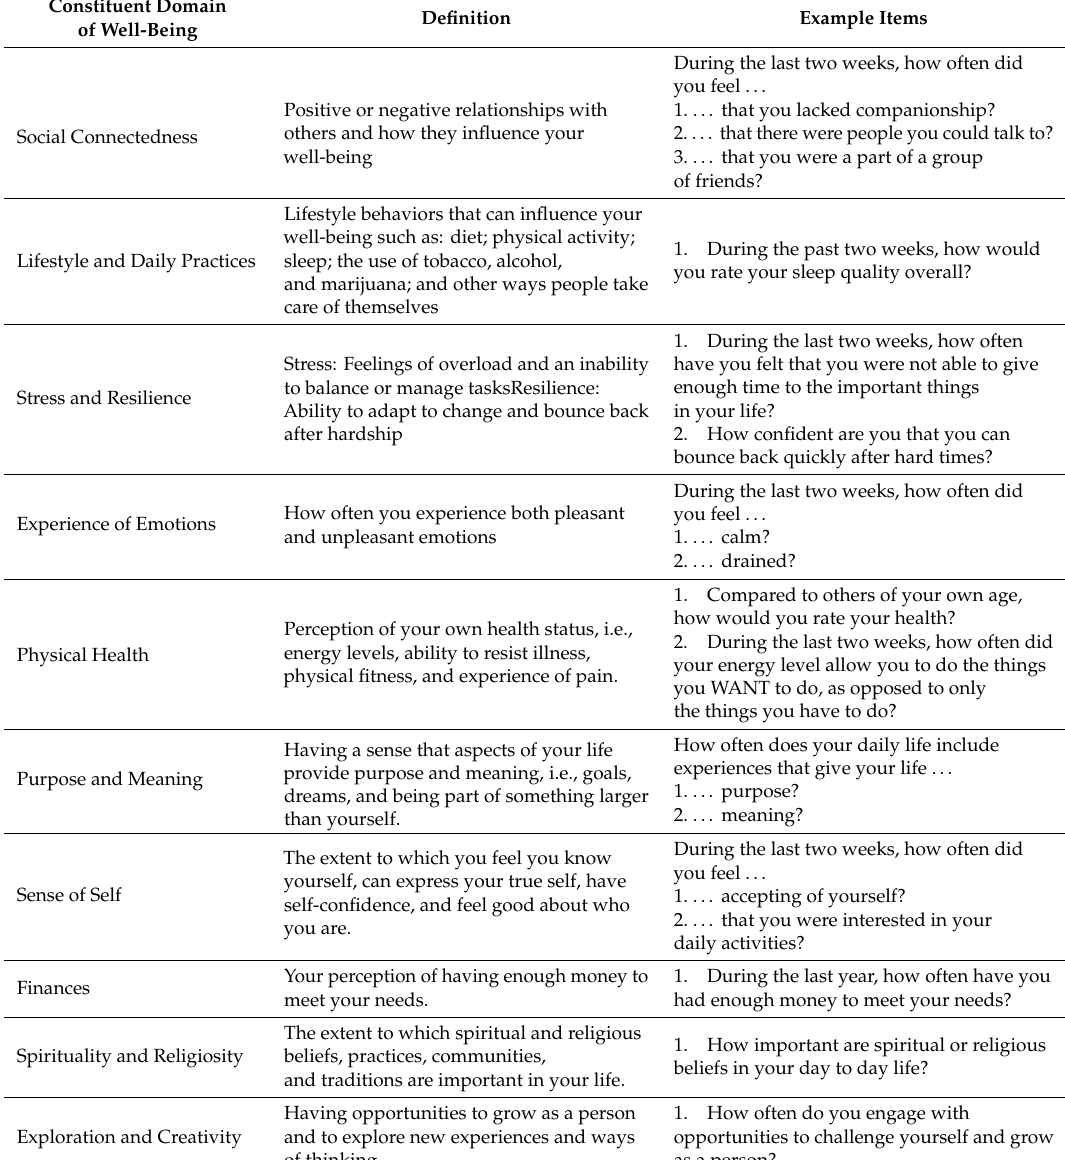
Table 1. Definitions of the 10 constituent domains of well-being measured in the Stanford WELL Survey with example